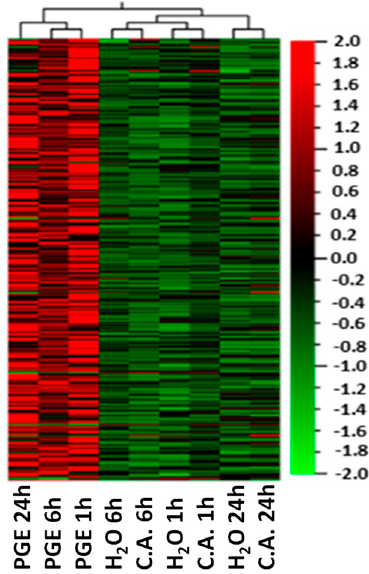
Figure 1. Hierarchical clustering heatmap of differentially expressed genes (DEGs) in orange fruit treated with PGE, citric acid (C.A.) or water (H 2 O) 1, 6 and 24 h post treatment (hpt). Colors indicate the level of expression as indicated in the scale on the right side of the figure.